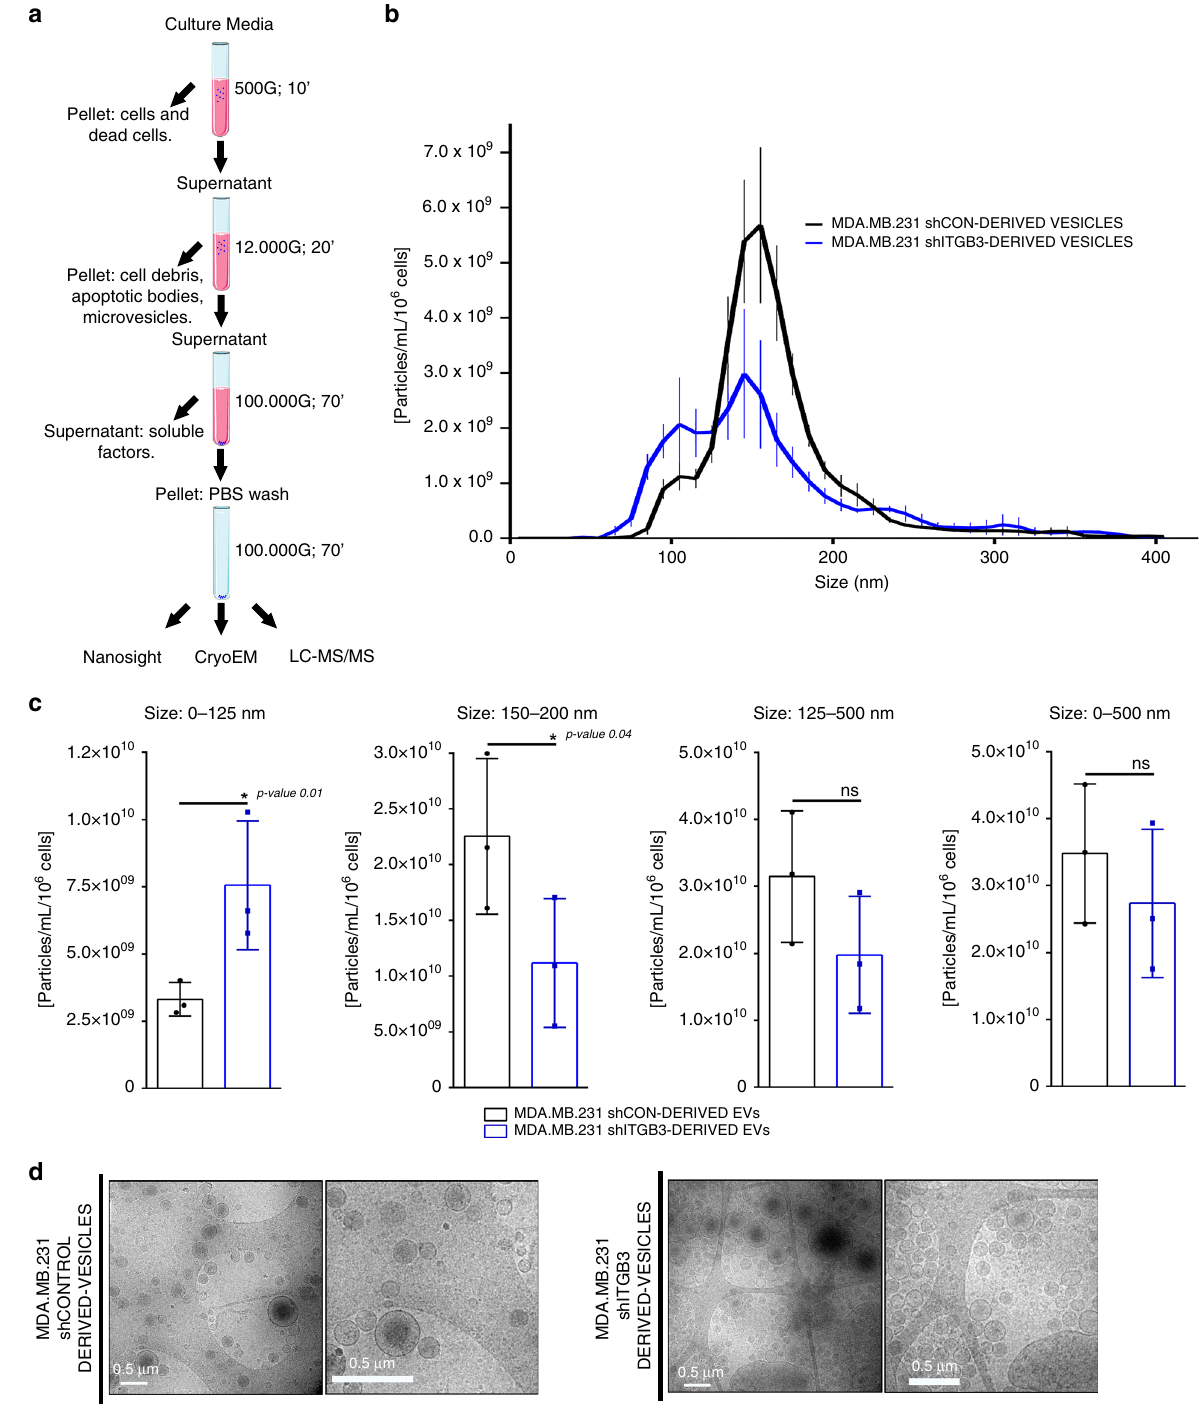
Fig. 4 Characterization of EVs isolated from shCON and shITGB3 cells. a Schematic work fl ow for the preparation of EV samples for LC – MS/MS analysis. b Vesicle size distribution based on NTA data. c Particle concentration of isolated vesicle fractions normalized per million cells. d Representative CryoEM images of EV isolated from cultured MDA.MB.231 shCON and MDA.MB.231 shITGB3 cells. Source data are provided as a Source Data fi le. Scheme created with BioRender (https://biorender.com/). (* p value < 0.05, n = 3). Data are represented as mean ± SD in ( b , c ). Statistical analysis including two-tailed unpaired Student ’ s t test data was carried out using GraphPad Prism